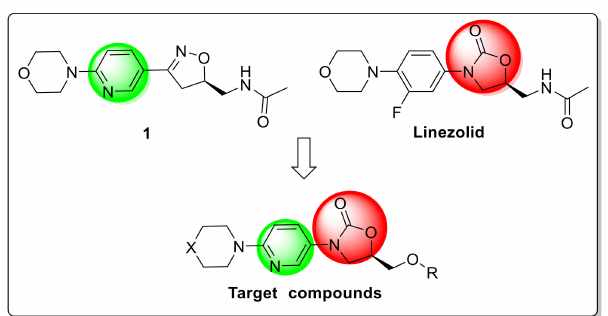
Figure 1. Design strategy of 3-(3-pyridyl)-oxazolidone-5-methyl ester